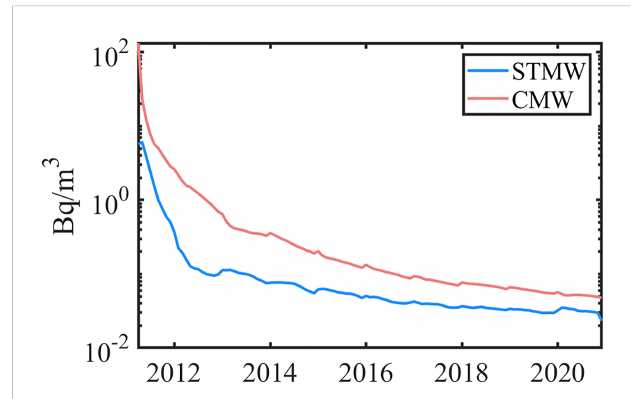
FIGURE 10 Time series of the spatial mean concentration of 137 Cs in STMW (blue line) and CMW (red line).